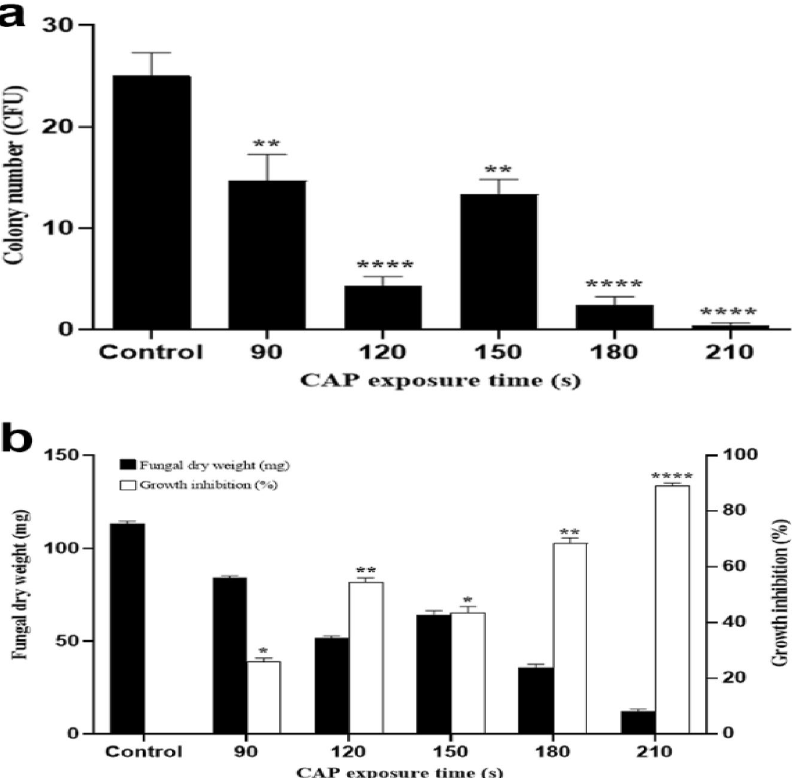
Figure 1. Colony number and dry weight of T. rubrum after CAP treatment for 90, 120, 150, 180, and 210 s in comparison to control group. The fungus was treated with CAP in three separate experiments and the results are represented in the graphs. ( a ) Number of T. rubrum colonies ( b ) Inhibition percentage of dry weight and growth. The error bar indicates the standard deviation. Asterisks show statistically significant difference with a control determined by ANOVA (* P < 0.05, ** P < 0.01, *** P < 0.001, **** P < 0.0001).